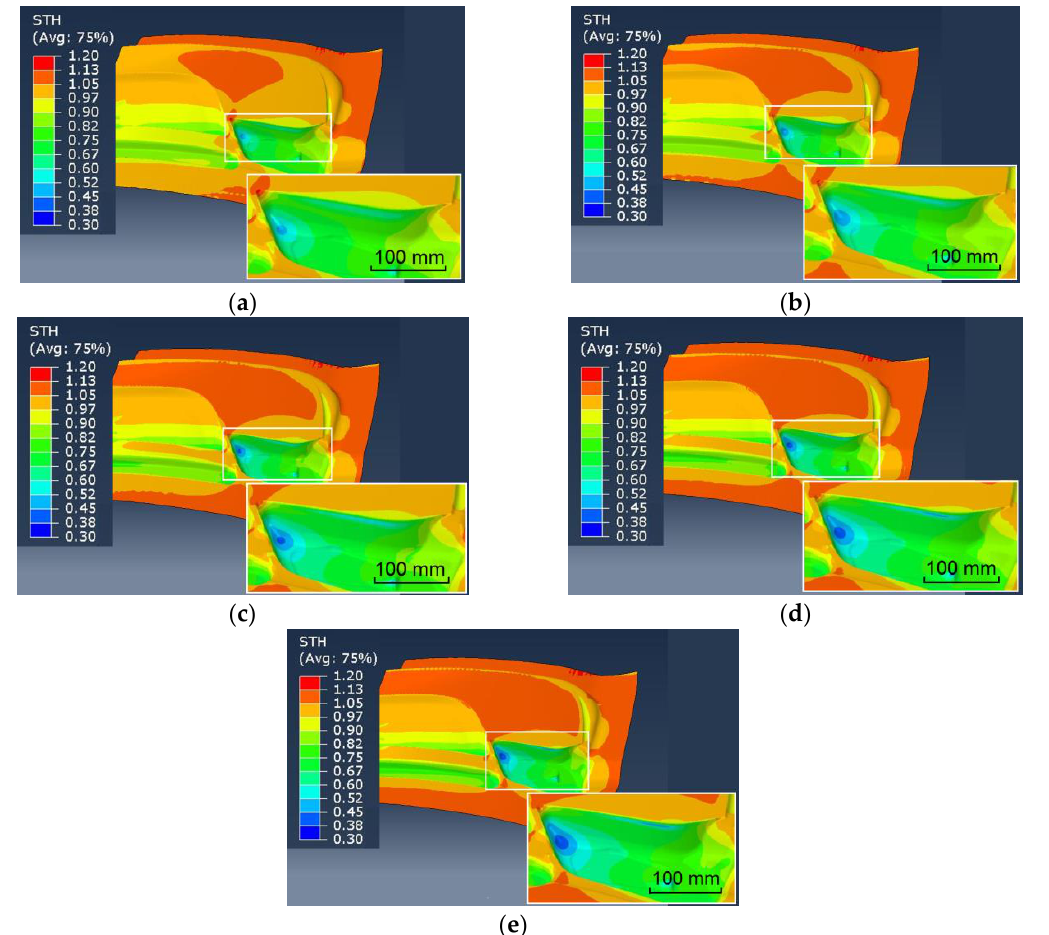
Figure 8. Predicted thickness variation within the part deformed with gas profile #2 (t: 100 s) assuming friction coefficient of: ( a ) 0.1; ( b ) 0.15; ( c ) 0.2; ( d ) 0.25; and ( e ) 0.3.